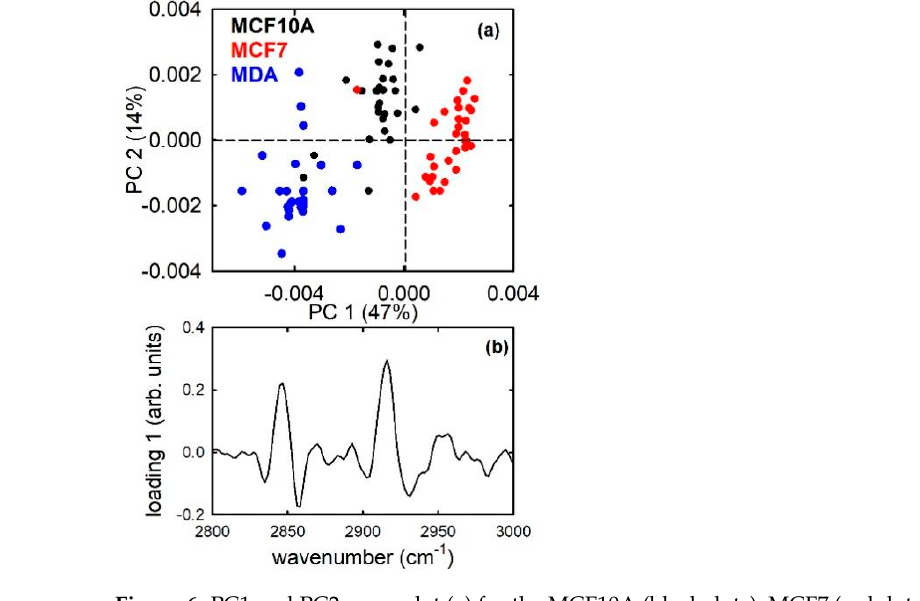
Figure 6. PC1 and PC2 score plot ( a ) for the MCF10A (black dots), MCF7 (red dots), and MDA (blue dots) cells and loading 1 spectrum ( b ). dots) cells and loading 1 spectrum ( b